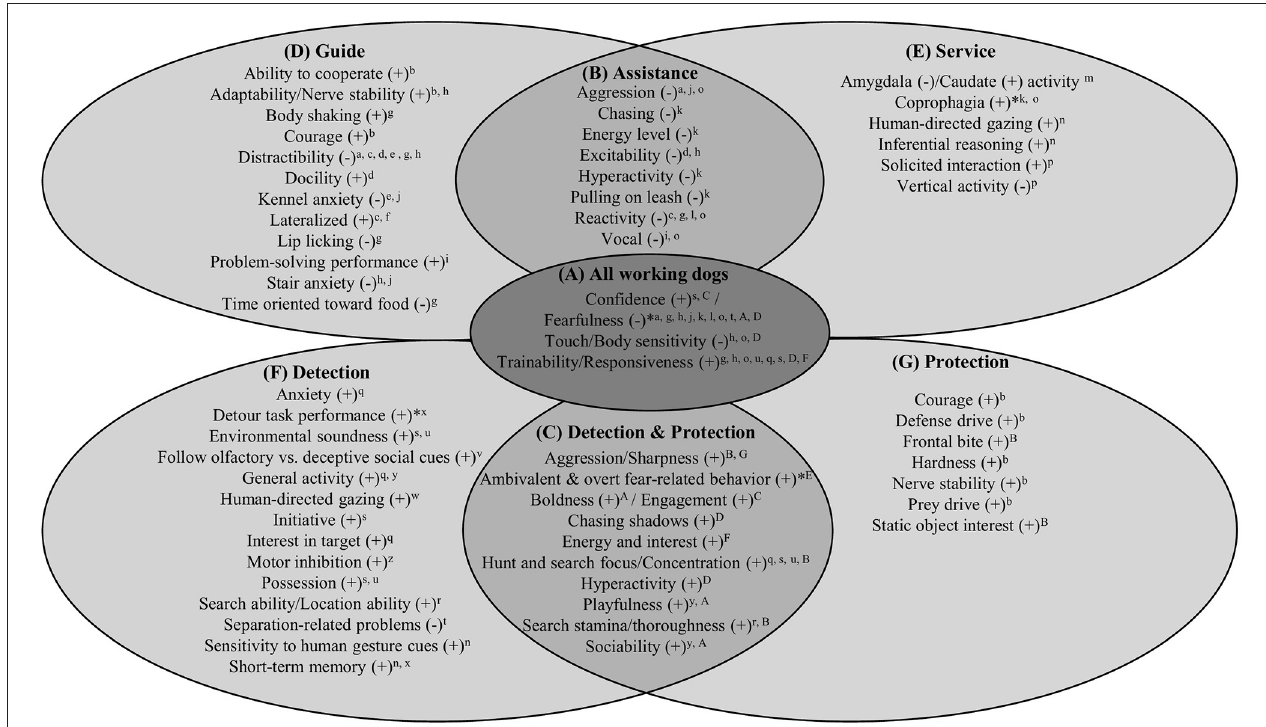
FIGURE 1 | Behavioral traits implicated in the literature as associated with working dog outcomes. Here, we list the traits that have either been positively ( + ) or negatively (–) linked to successful working dog outcomes, categorized in the following ways: (A) traits common to all working dogs within the scope of this paper, (B) traits common to all assistance dogs, (C) traits common to all detection and/or protection dogs, as well as distinct traits unique to (D) guide, (E) service, (F) detection, and (G) protection dogs. These lists of traits are based on findings from the 33 empirical studies described in Table 1 , and we have preserved the terminology used in the original papers. The relevant papers are referenced in superscript next to each finding, using the letters assigned to each paper in the first column of Table 1 . It is worth noting that these findings are merely a reflection of the current literature; therefore, it could be the case that some of the traits that are only listed as important for guide dogs might also be important in service dogs, but the association has yet to be explicitly tested. In rare cases, the empirical studies supported contradictory results, and in those instances the disagreements are indicated with an